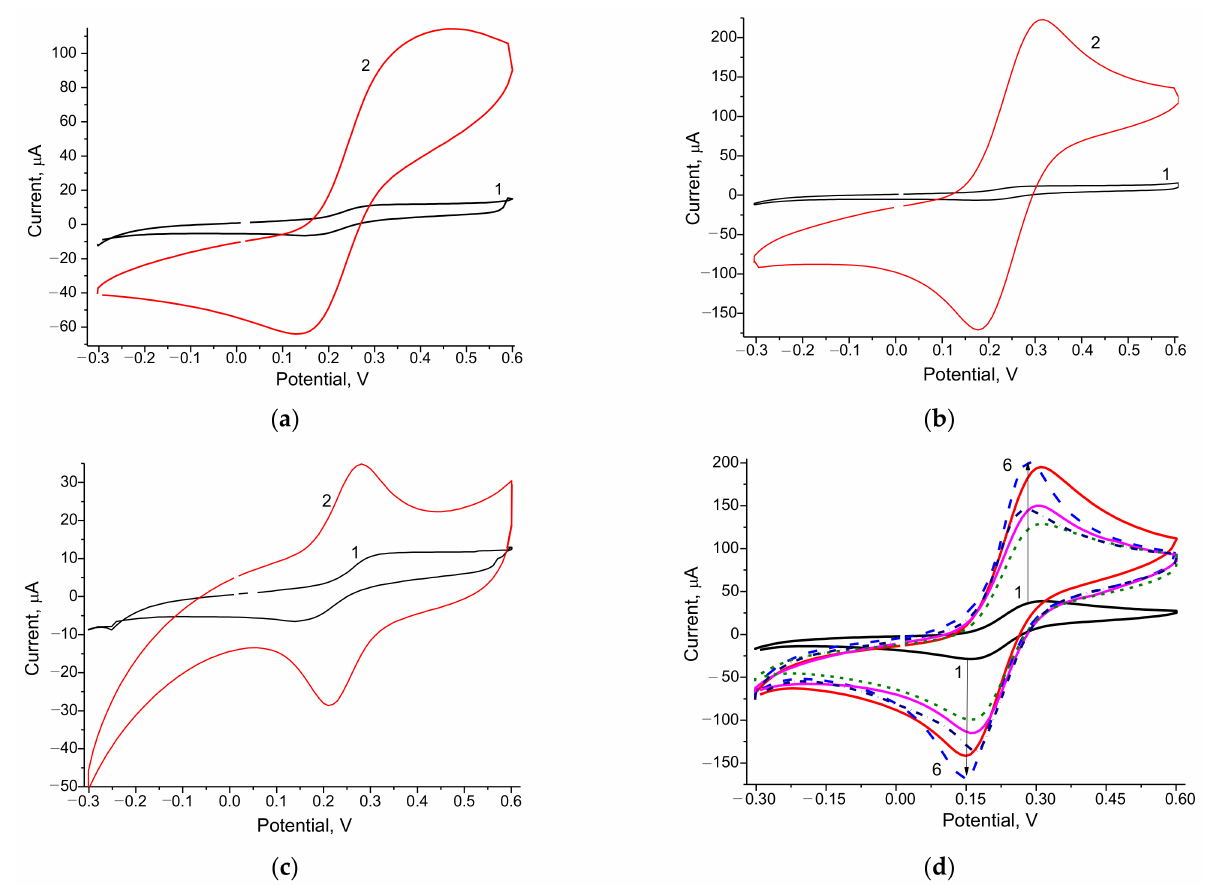
Figure 1. CV profiles as outputs from increasing concentrations of K 3 Fe(CN) 6 of the control electrode GE (1— a – d ) and the modified electrodes: PdHCF/GE ( a , 2); CuCo/GE ( b , 2); NiPtPd/GE ( c , 2); PtCeHCF/GE ( d , 2), AuCoHCF/GE ( d , 3), AuHCF/GE ( d , 4), PtHCF/GE ( d , 5), AgHCF/GE ( d ,